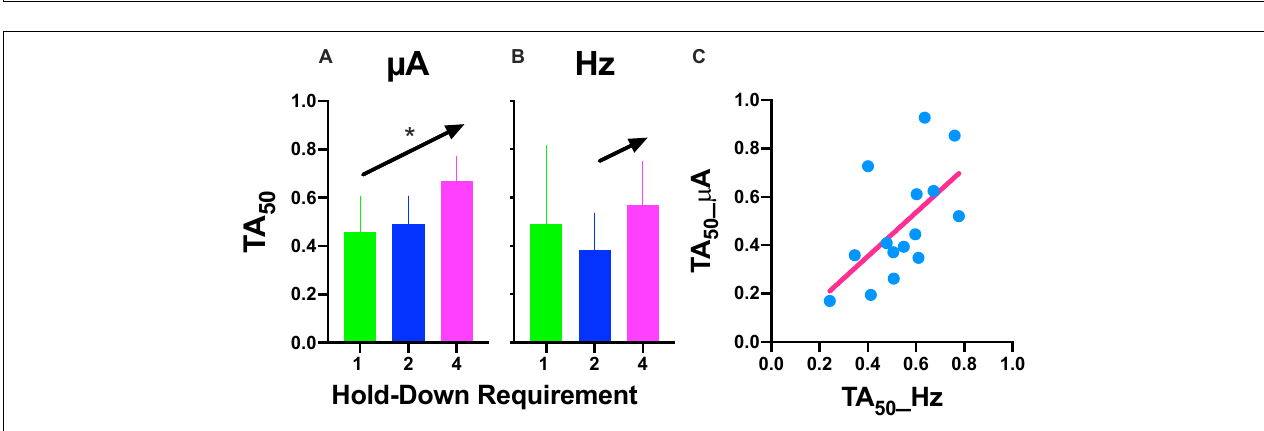
FIGURE 5 | Time allocation as a function of variations of frequency (in common scale, see text) and price (hold requirements). Abscissas in log scale. (A) Exemplar rat. (B) Remaining rats.